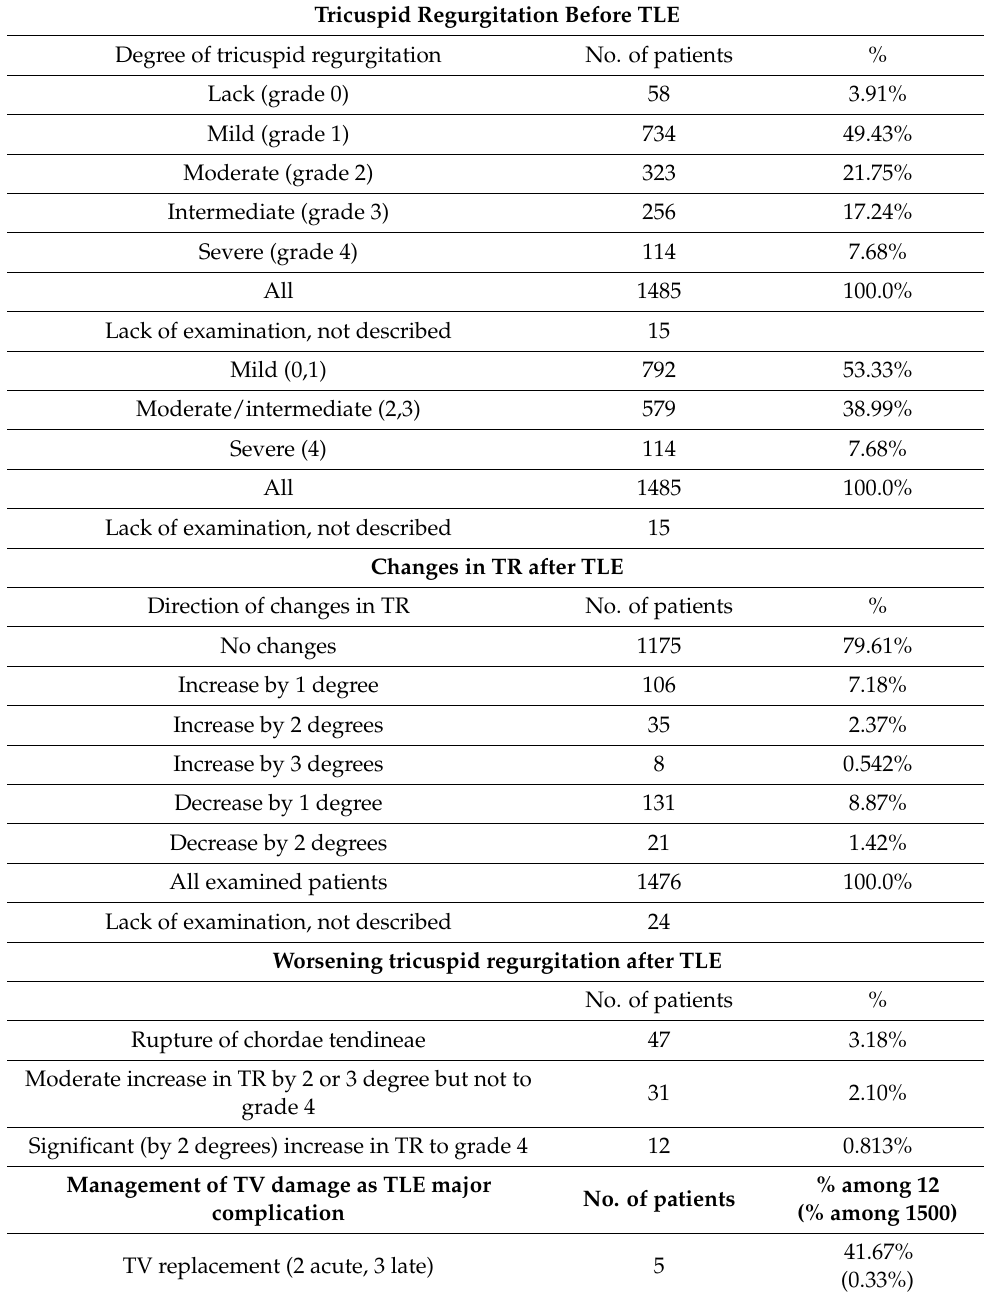
Table 6. Analysis of tricuspid valve function before and after